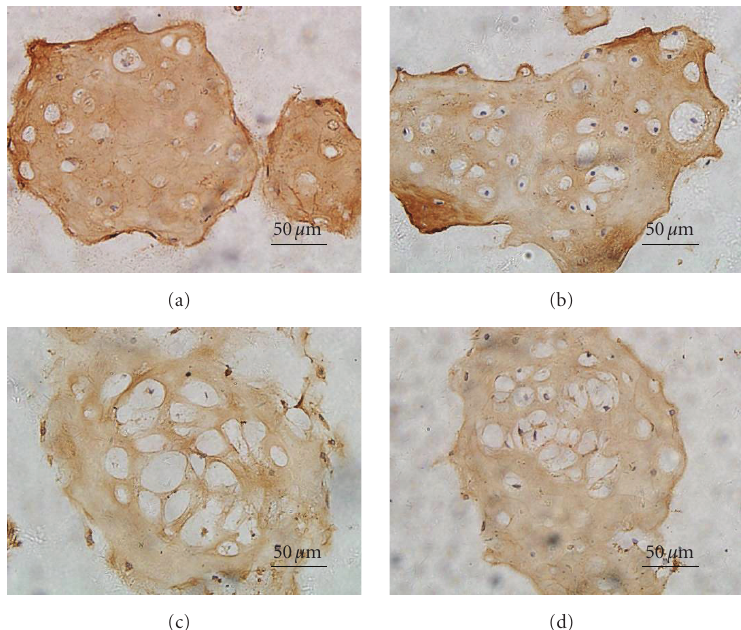
Figure 3: Immunohistochemical staining for chondrocyte-seeded alginate hydrogels maintained in (a) medium supplemented with 1% ITS plus 2% FBS, (b) medium with 1% ITS plus 4% FBS, (c) medium with 1% ITS plus 8% FBS, or (d) medium with 10% FBS for 21 days. The scale bars indicate 50 μ m.